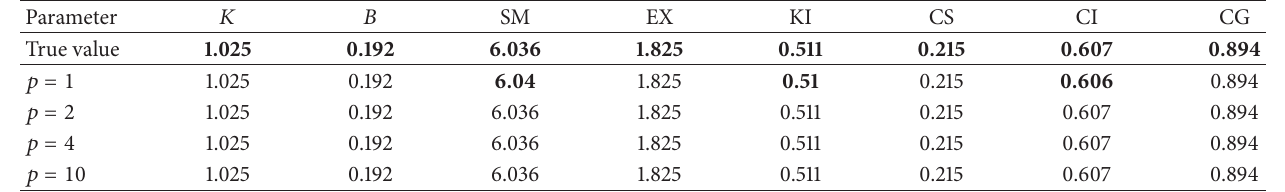
Table 4: Optimization results for the remaining parameters after fixing some parameters, using the ideal